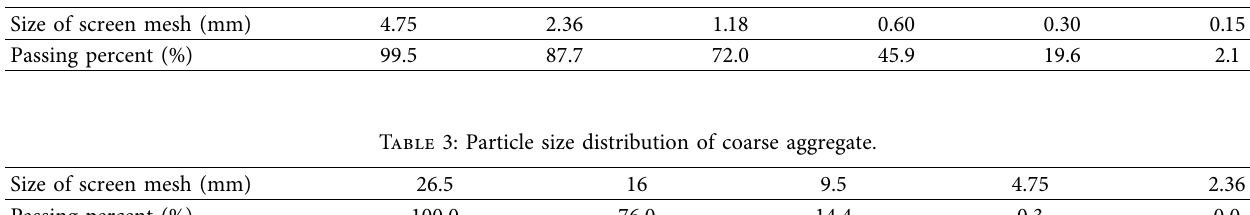
Table 2: Particle size distribution of fine aggregate.